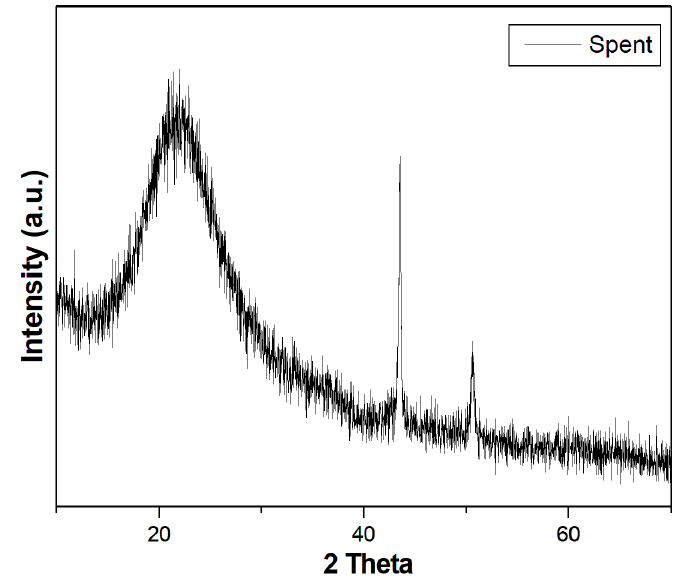
Figure 12. XRD pattern of spent 5 wt% Cu/SiO 2